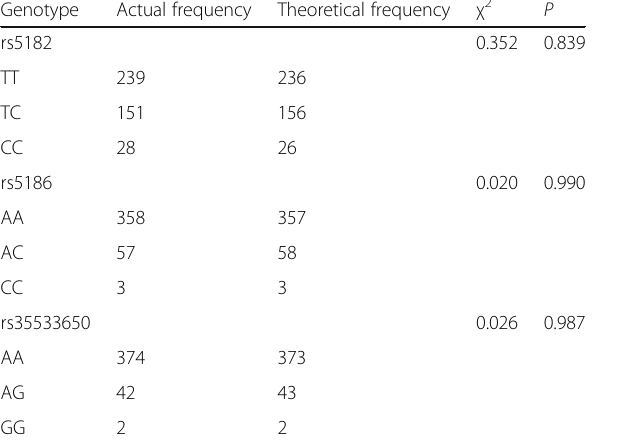
Table 4 Hardy-Weinberg equilibrium status of the three AT1R gene the correct variation type Genotype